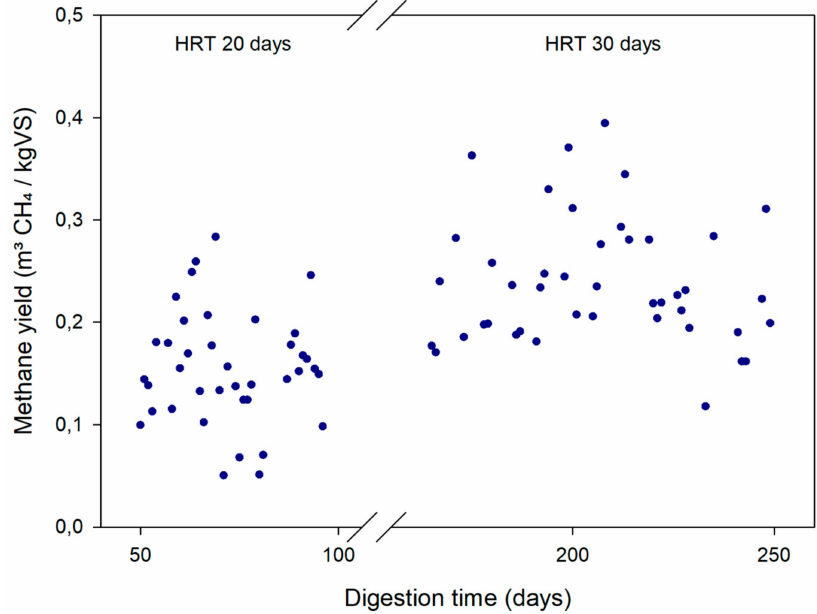
Figure 5. Daily methane yield of thermally pretreated microalgae for the two studied periods: Period I at an HRT of 20 days and Period II at an HRT of 30